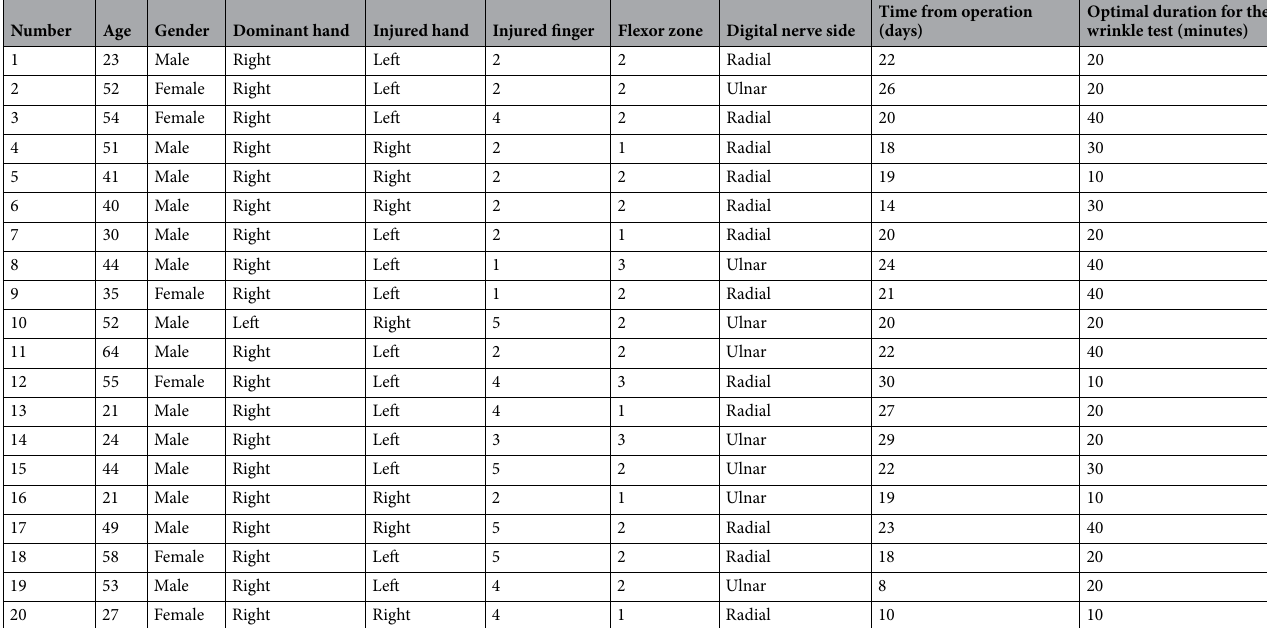
Table 1. Patient’s demographics, injury characteristics and